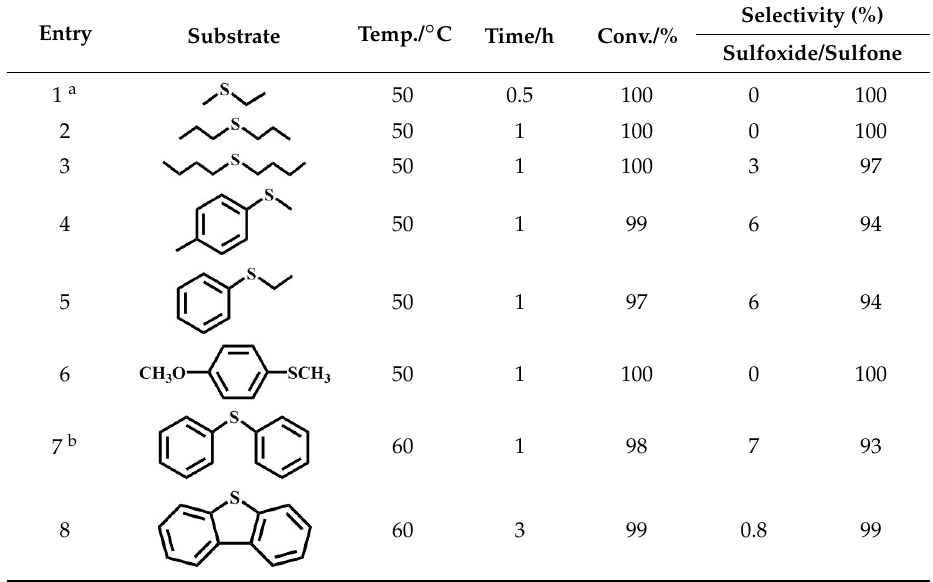
Table 3. Oxidation of various sulfides with H 2 O 2 in the presence of the catalyst in acetonitrile. Selectivity (%) Entry Substrate Temp./°C Time/h Conv./%